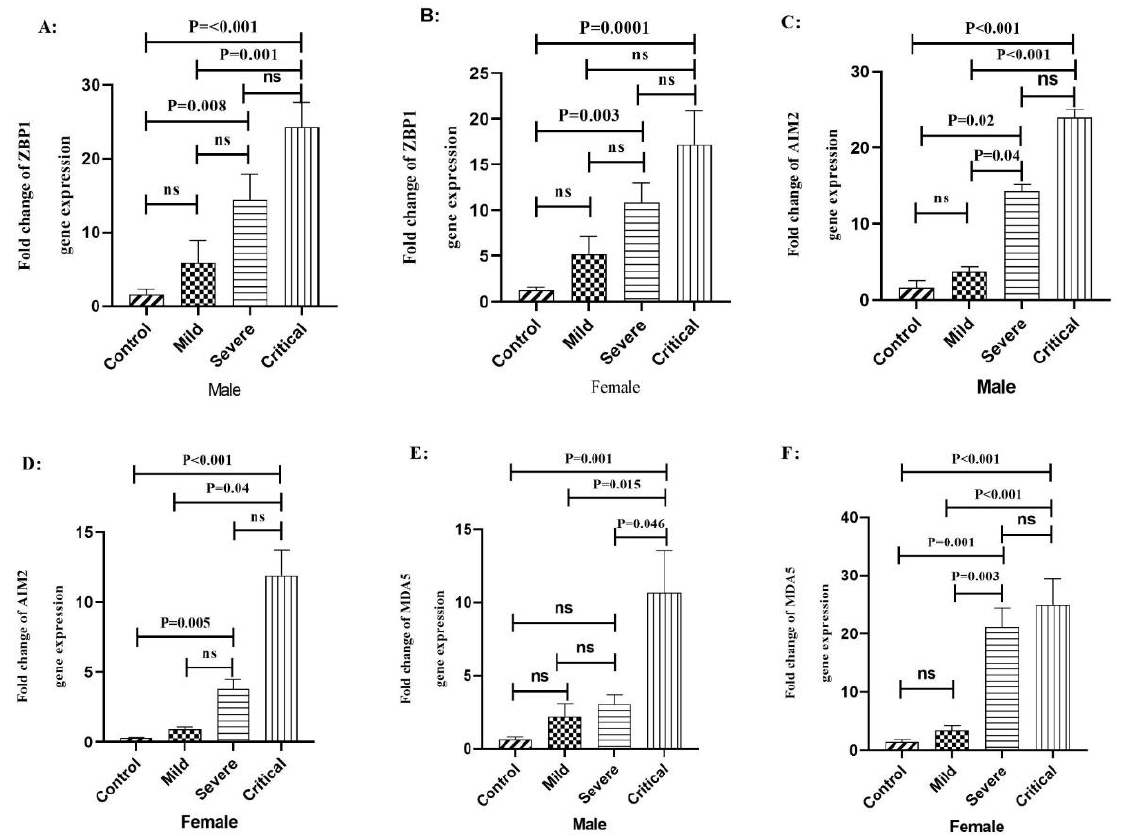
Figure 4: The expression level of ZBP1, AIM2, and MDA5 genes in male and female patients with COVID-19 according to the outcome of disease and gender. A) The expression level of ZBP1 gene in male COVID-19 patients. B) The expression level of ZBP1 gene in female COVID-19 patients. C) The expression level of AIM2 gene in male COVID-19 patients. D) The expression level of AIM2 gene in female COVID-19 patients. E) The expression level of MDA5 gene in male COVID-19 patients. F) The expression level of MDA5 gene in female COVID-19 patients. Data are presented as fold change. ns: not significant. There is a difference between the specified groups (p <